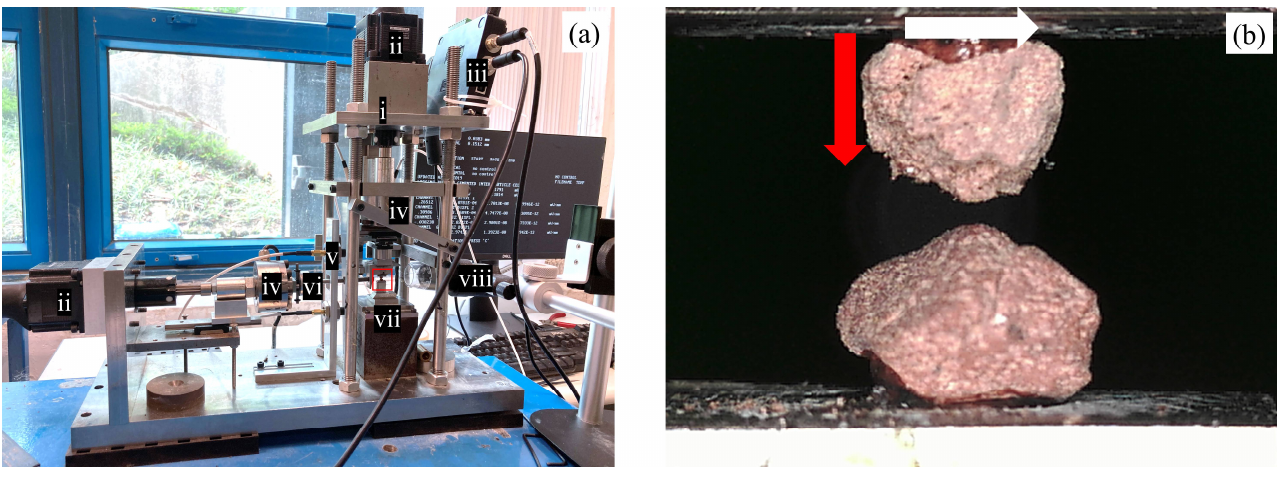
Figure 2. Experimental setup: ( a ) Micromechanical loading apparatus with its different components marked (i) rigid frame (ii) linear actuators (iii) motor controllers (iv) load cells (v) non-contact displacement transducers (vi) shear loading arm (vii) rigid base (viii) digital micro-camera. ( b ) Close view of particle arrangement for micromechanical testing (red arrow indicates normal loading and white arrow indicates tangential loading).